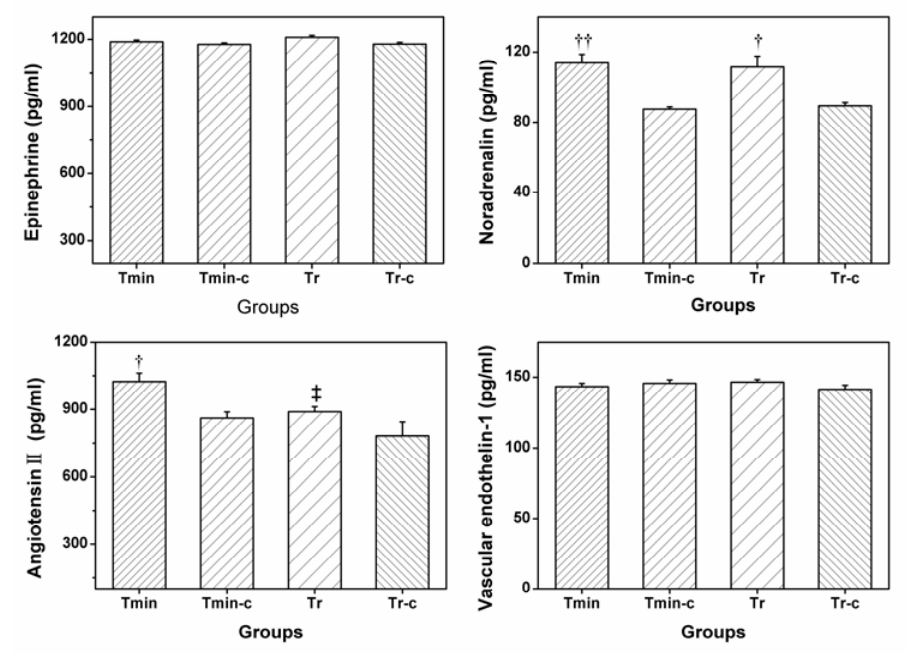
Figure 2. Norepinephrine, epinephrine, endothin l and angiotensin II in different groups (n = 6). Compared with control group † P < 0.05, †† P < 0.01; compared with Tmin group ‡ P < 0.05.